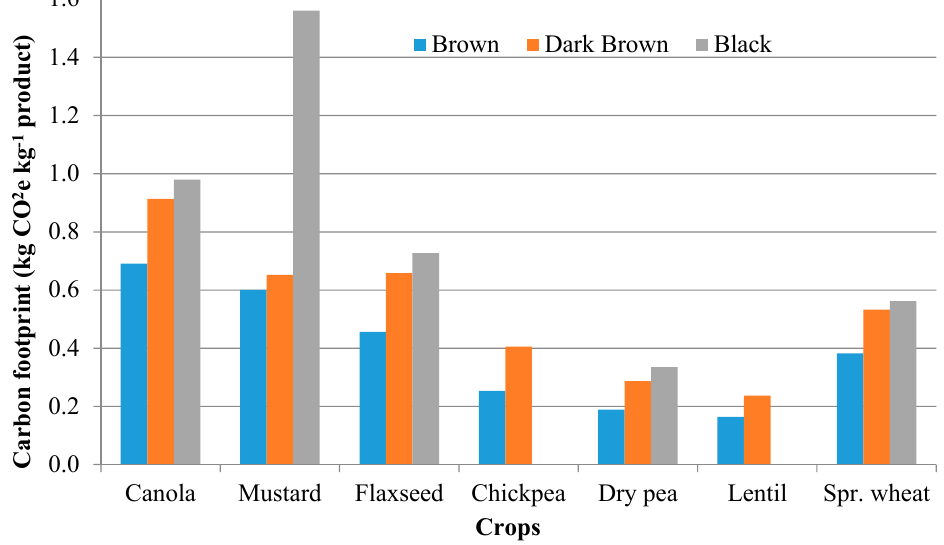
Figure 9. The carbon footprint of durum wheat preceded by different crops in a rotation; they were significant at the p < 0.01 level across the treatments (adapted from Gan et al., 2011b). Studies have shown that hard red spring wheat grown on the Canadian prairie can have NUE averaging 10.9 kg grain kg − 1 available N or 0.3 kg grain N kg − 1 available N (where available N